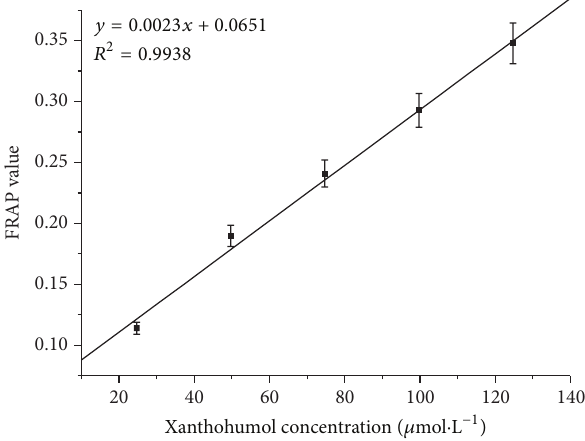
Figure 7: A representative calibration curve between Xanthohumol concentration and FRAP values percentage rate. 𝑌 = 0.0023𝑥 + 0.0651 and 𝑅 2 = 0.9938 ( 𝑛 = 3